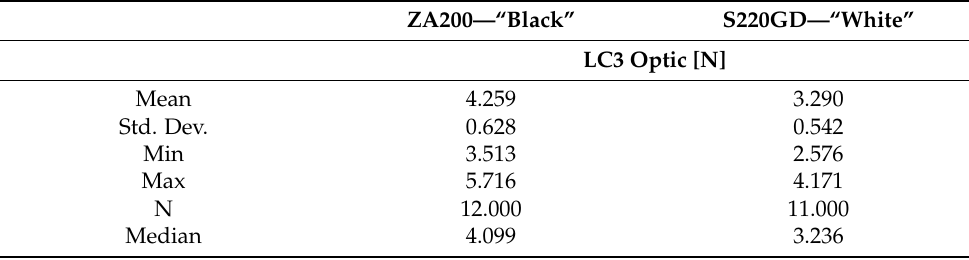
Figure 8. SEM images of the investigated coatings: ( a ) cross-section of the “white” coating (1000×); ( b ) cross-section of the “black” coating (1000×); ( c ) cross-section of the “white” coating (10,000×). Table 3. Descriptive statistics of the results of the adhesion tests of the roof sheet